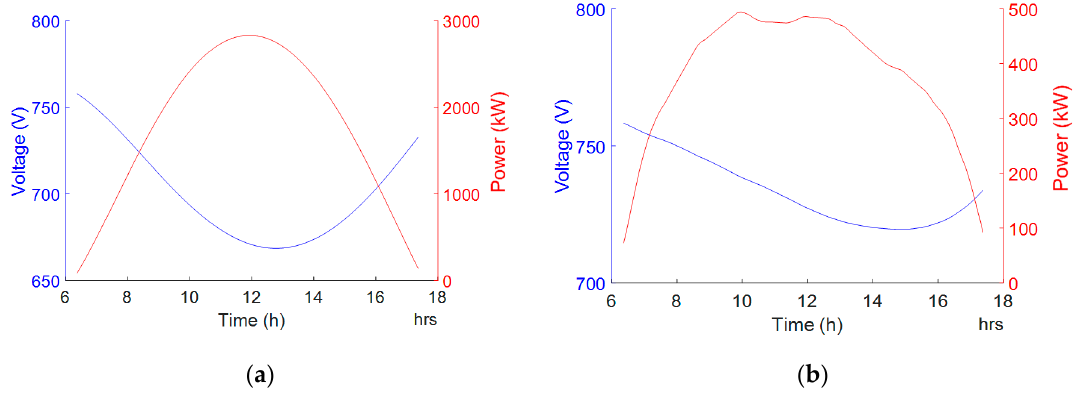
Figure 16. Daily power generation and MPPT voltage curves. ( a ) Sunny day. ( b ) Cloudy day.